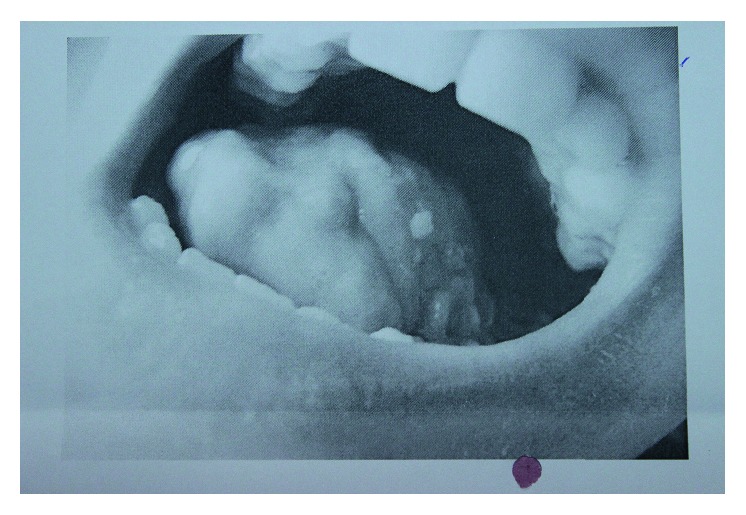
Painful oral ulcer.